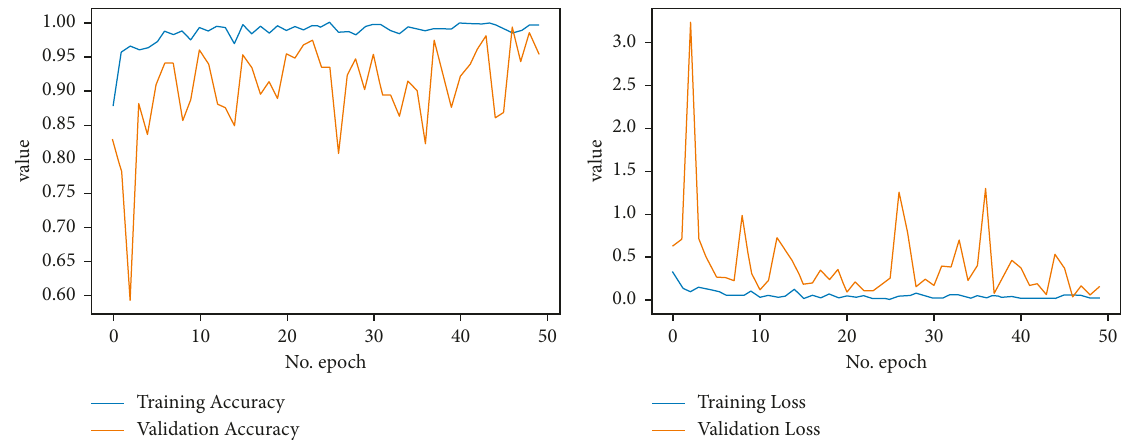
Figure 8: Variations in model accuracy and loss at the training and testing analysis. Table 5: Model metrics assessment without stacking